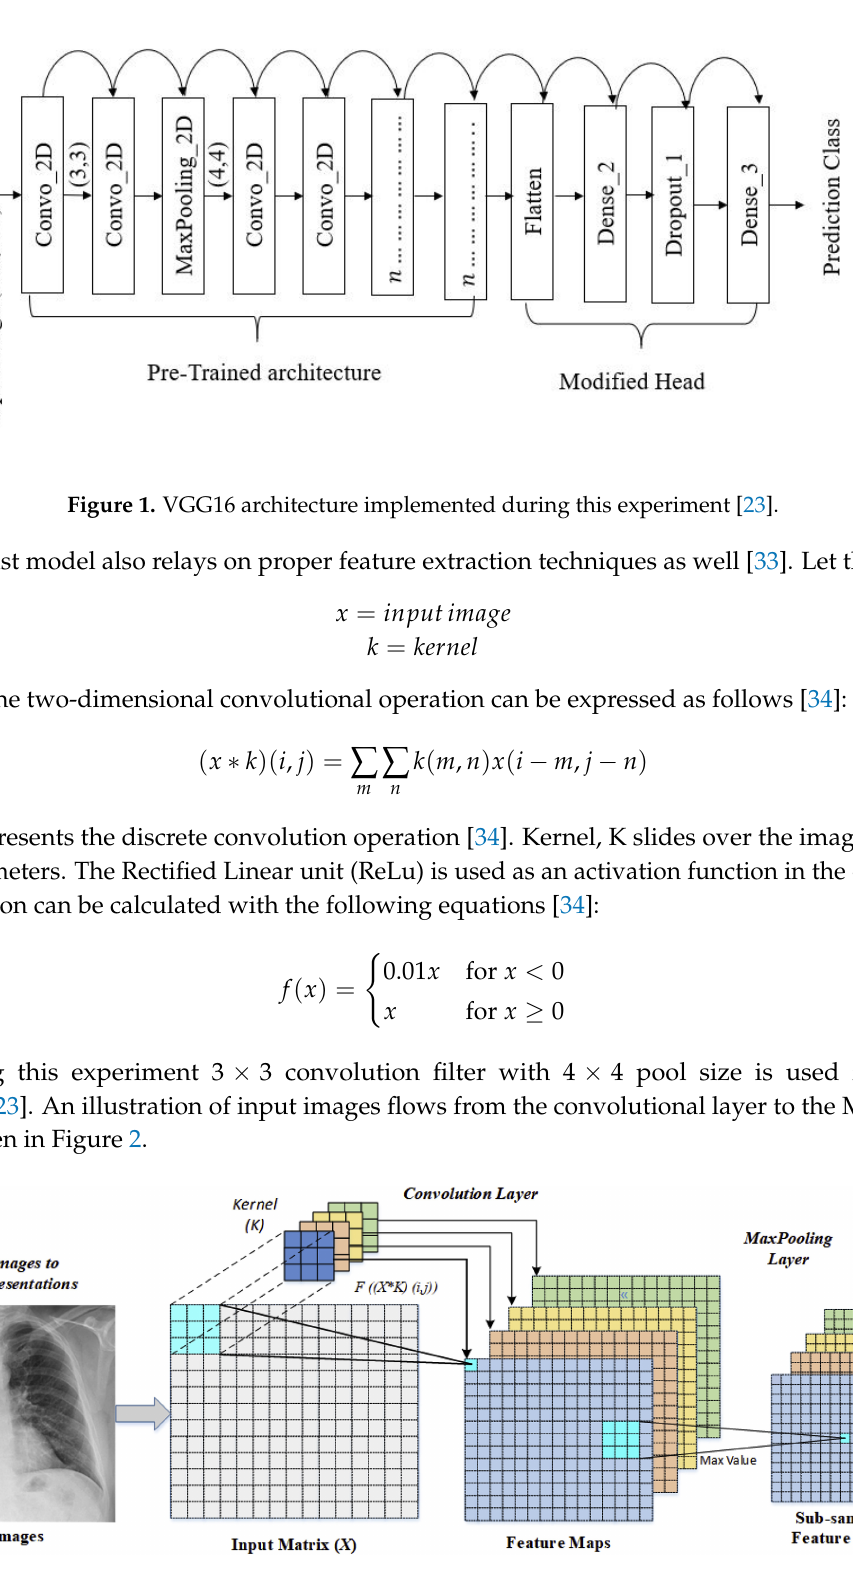
Figure 2. An illustration of convolutional and maxpooling layer operations